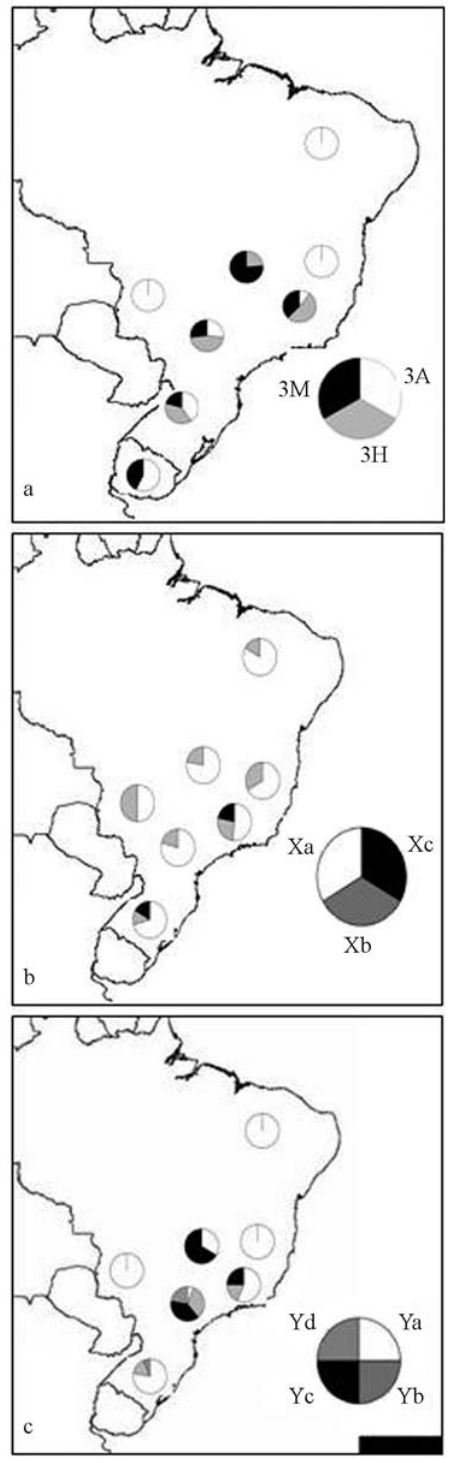
Figure 5 - Geographical distributions of the frequencies of the polymor- phic forms of (a) pair 3, (b) X chromosomes and (c) Y